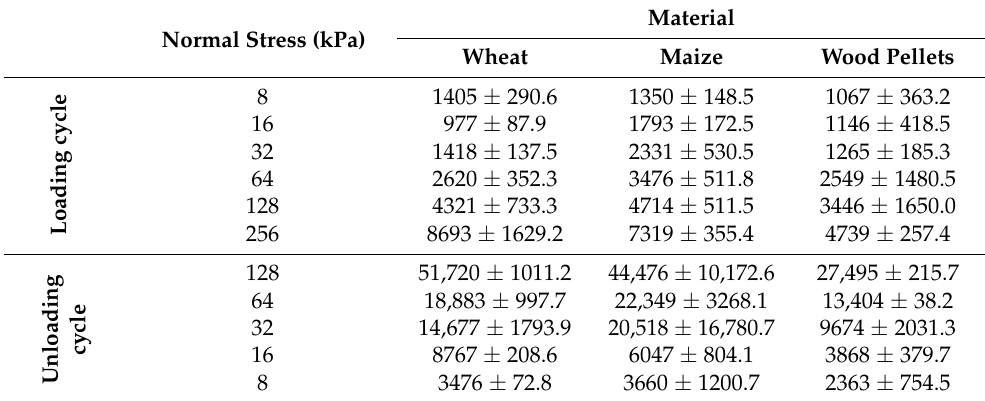
Table 6. Young’s modulus for the different materials as obtained in the oedometric assays. Values are expressed in